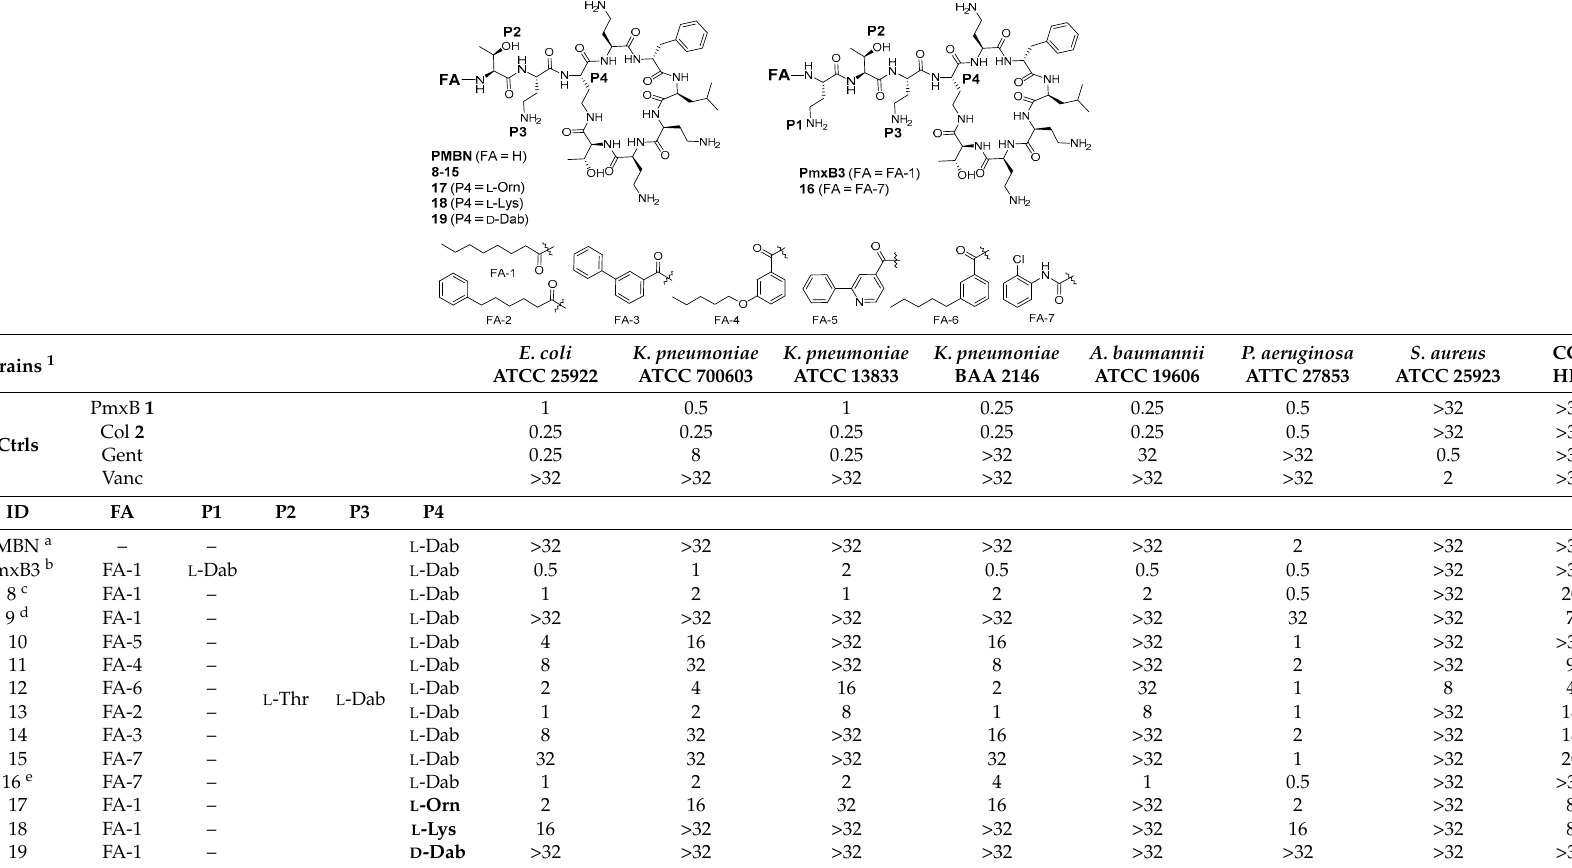
Table 1. Summary of antimicrobial activity (MIC, mg/ L ) and cytotoxicity (CC 50 , µM) against HK-2 Cells for a series of polymyxin-B nonapeptide (PMBN) derivatives acylated with different fatty acids and varying the P4 residue.